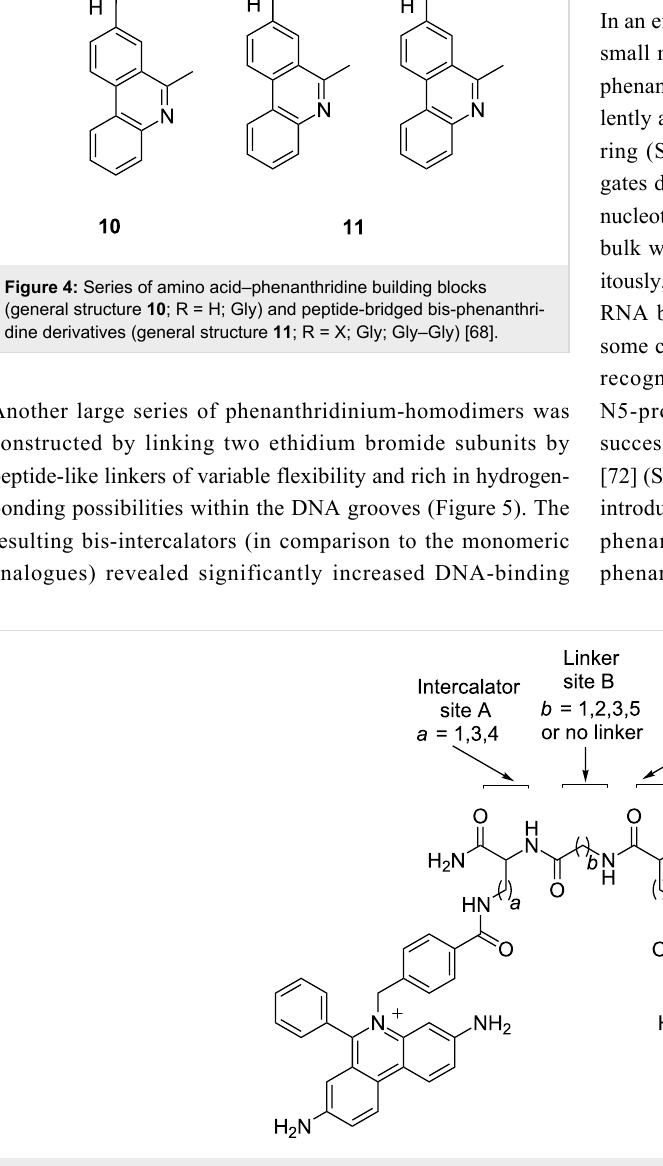
Figure 5: General structure of 45 bis-ethidium bromide analogues. Reproduced with permission from [69]. Copyright 2012 Elsevier Ltd.